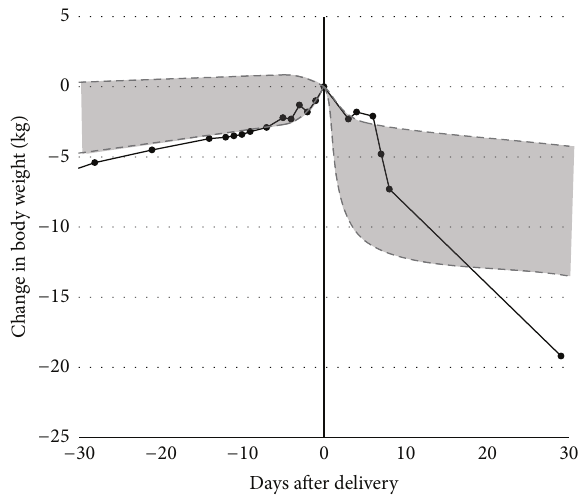
Figure 1: Changes in body weight in a PPCM woman with preeclamptic twin pregnancy. Shaded area indicates the 5th–95th percentile range for 90 women giving birth to twins at gestational week ≥ 32 at Hakodate Central General Hospital. The solid line indicates the present